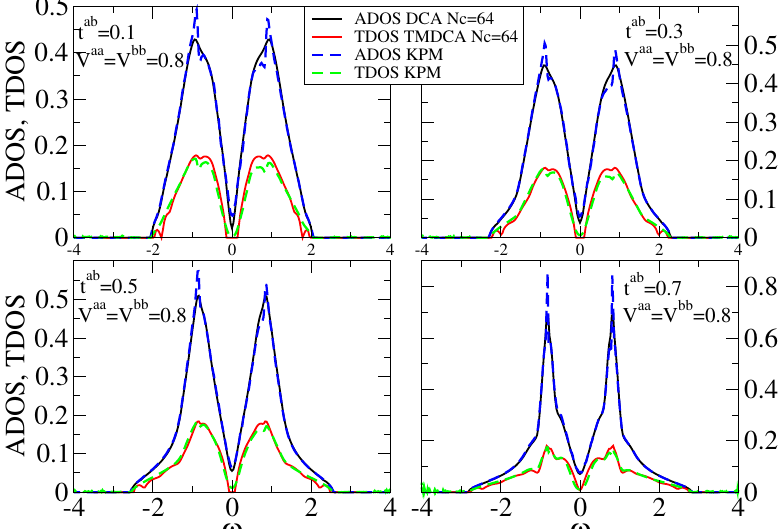
Figure 37. Comparison of the ADOS and TDOS of the a-b two-orbital model calculated with the DCA, TMDCA and KPM with fixed disorder strength V aa = V bb = 0.8 with impurity concentration x = 0.5 and various values of the inter-band hopping t ab . The KPM uses 2048 moments on a cubic lattice of size 48 3 and 200 independent realizations generated with 32 sites randomly sampled from each realization. Reprint from